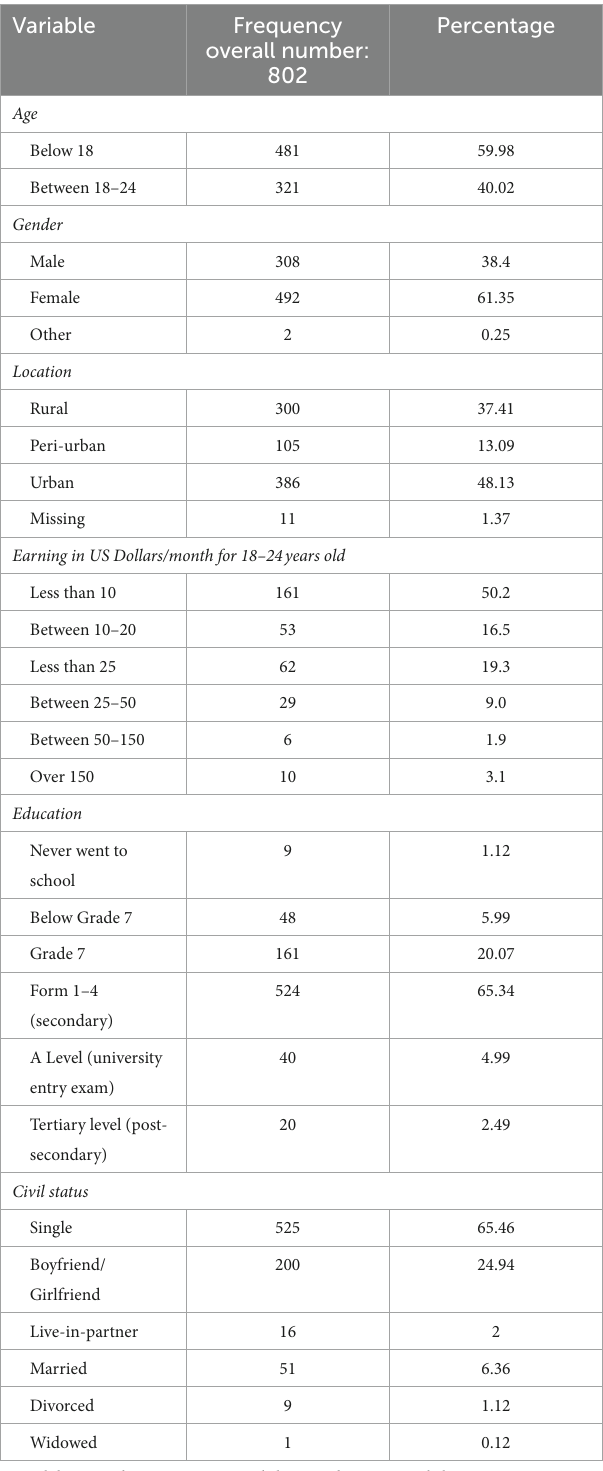
TABLE 1 Participants’ sociodemographic characteristics in frequency and